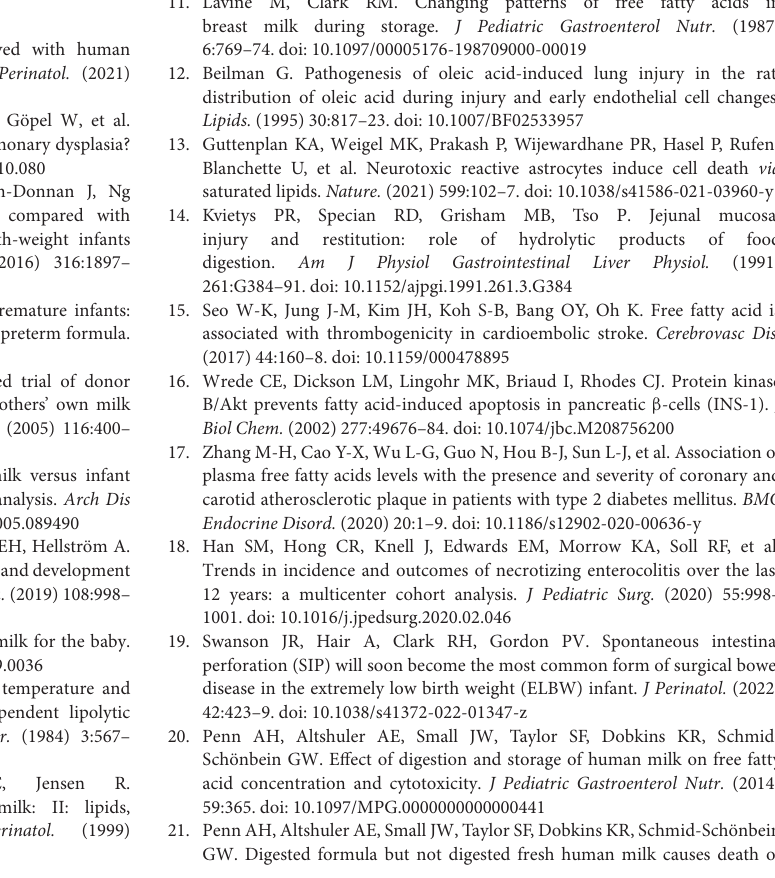
Supplementary Figure 1 | Flow chart of patient enrollment, sample collection and testing. Mothers ( n = 15) donated milk samples ( n = 34), which were repeatedly tested ( n = 55) until cytotoxicity was observed. All tests observed with corresponding storage days. One sample had 4 viability tests. Supplementary Figure 2 | Range of milk samples. Preterm mothers ( n = 15) donated milk samples ( n = 34) over batches donated (1st, 2nd, and 3rd). Samples covered a range of storage times before viability testing, ranging from 2 days to 199 days. Supplementary Figure 3 | Cytotoxicity and FFA species present. In a simple linear regression model of FFA concentration vs. cytotoxicity without adjustment. All subjects ( n = 15), viability tests n = 55 were included in this model. Total FFA were not included in the model due to rejection secondary co-linearity with C18:1 (variance 0.82). SPSS 27.0, p < 0.05 is significant. Supplementary Figure 4 | Summary of linear regression modeling. Coefficients per FFA species and cytotoxicity adjusted for batch effects and selected for the 5 most prevalent FFA concentrations. All subjects ( n = 15) with HPLC-MS/MS FFA analysis coupled with viability tests ( n = 39) were included in this model. Enter-method regression with SPSS 27.0, p < 0.05 is